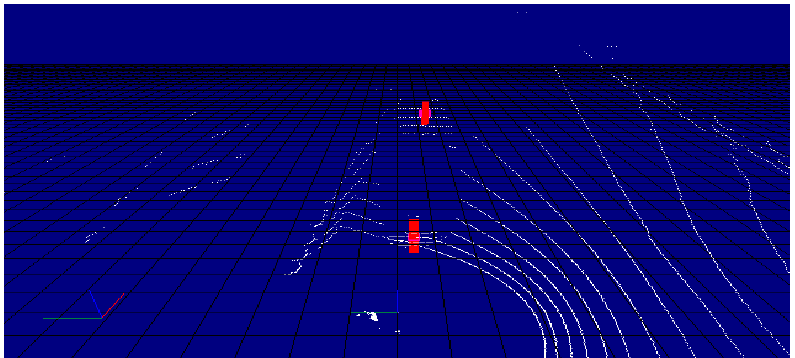
Figure 36. The tracked position represented with a red column in the point